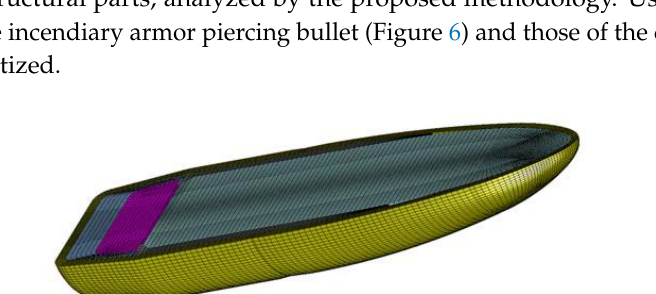
Figure 5. Composite plate welded by explosion.